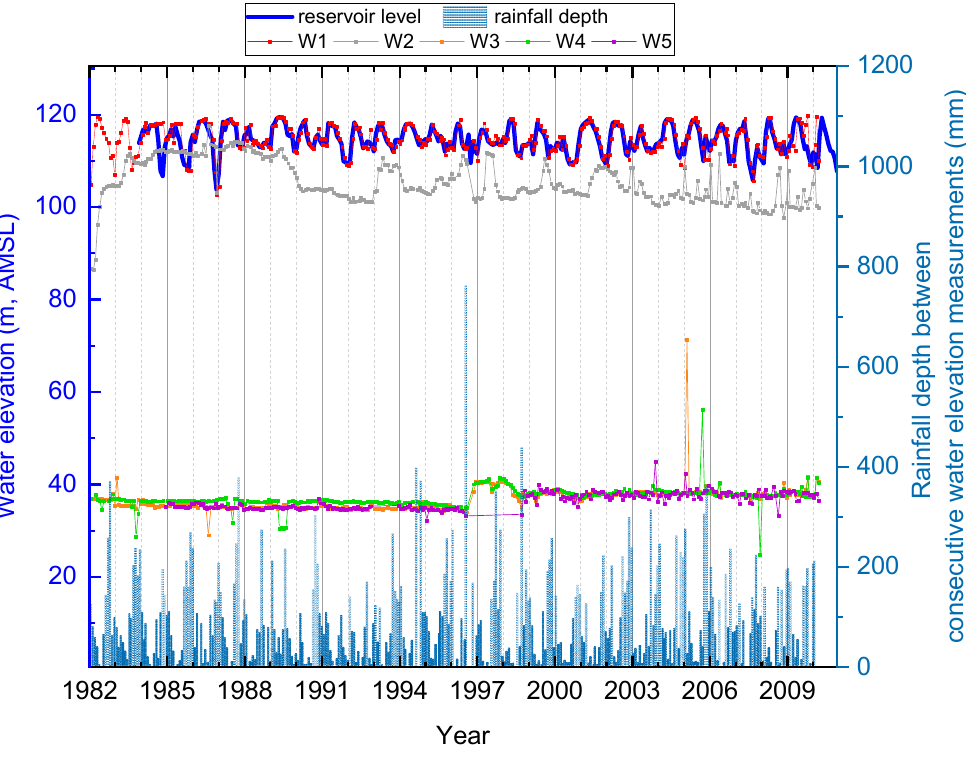
Figure 13. Variation of water level elevation along cross-section A-A. Changes of the reservoir level appear immediately at the D/S shoulder, the core (at centre axis) appears to respond with a varying time lag. The phreatic surface in the D/S shoulder is unaffected by the reservoir-level variations in the reservoir.